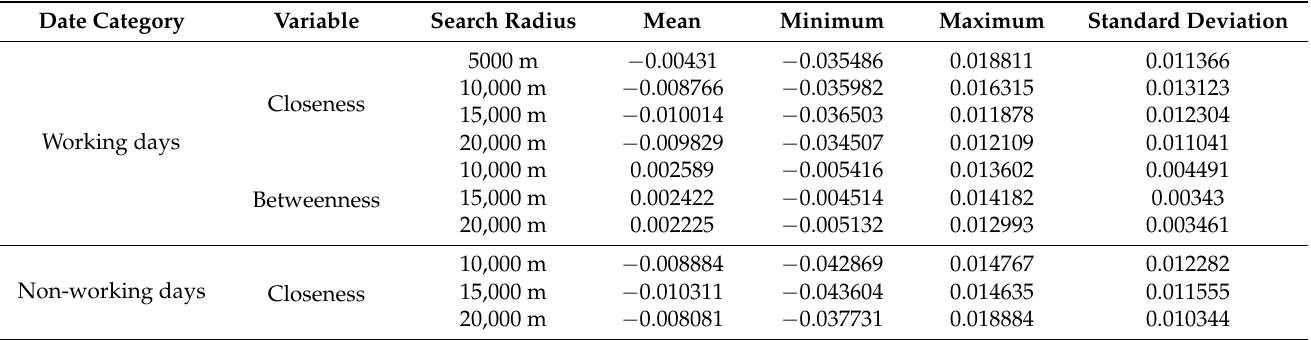
Table 7. Regression coefficient results of road network topological